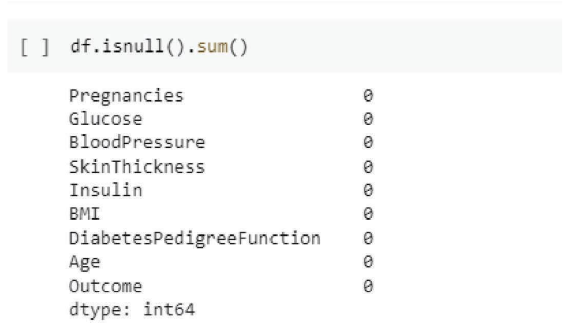
Figure 6: After data